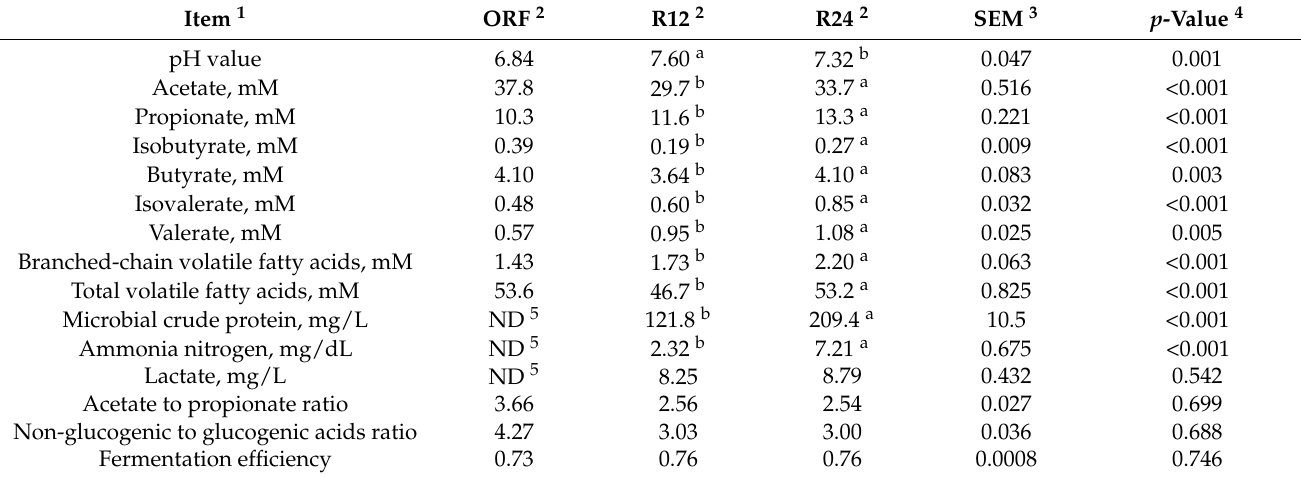
Table 2. Rumen fermentation characteristics as in vitro rumen fermentation advanced.